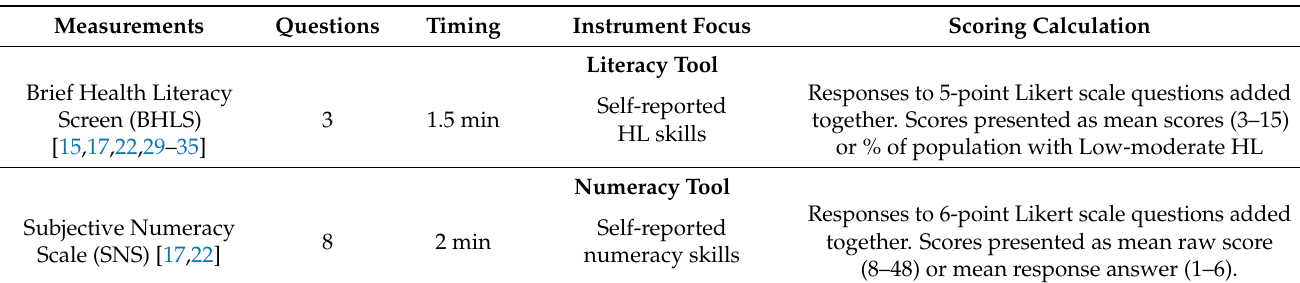
Table 2. Indirect assessment of health literacy and numeracy instruments found in publications having Hispanic populations with